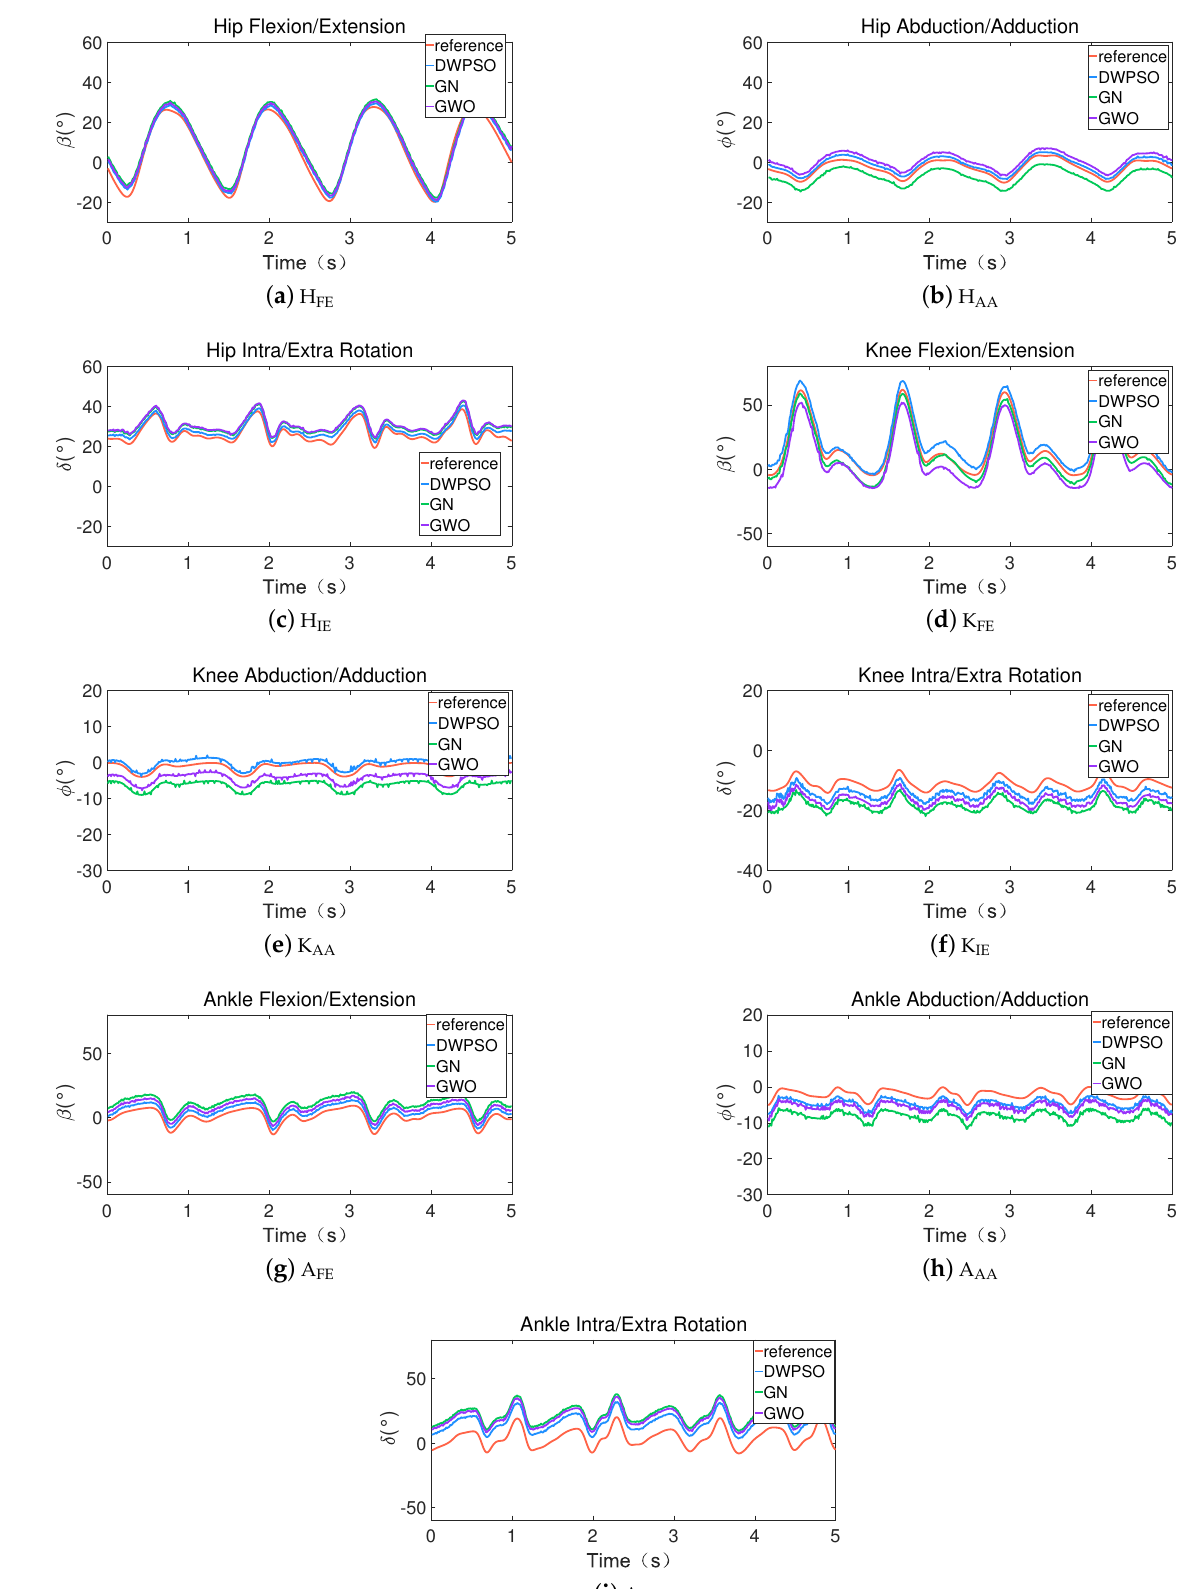
Figure 12. The variation of the joint DOF when IMUs on subject 1 were bound in position 1. ( a – c ) The hip joint; ( d – f ) the knee joint; ( g – i ) the ankle